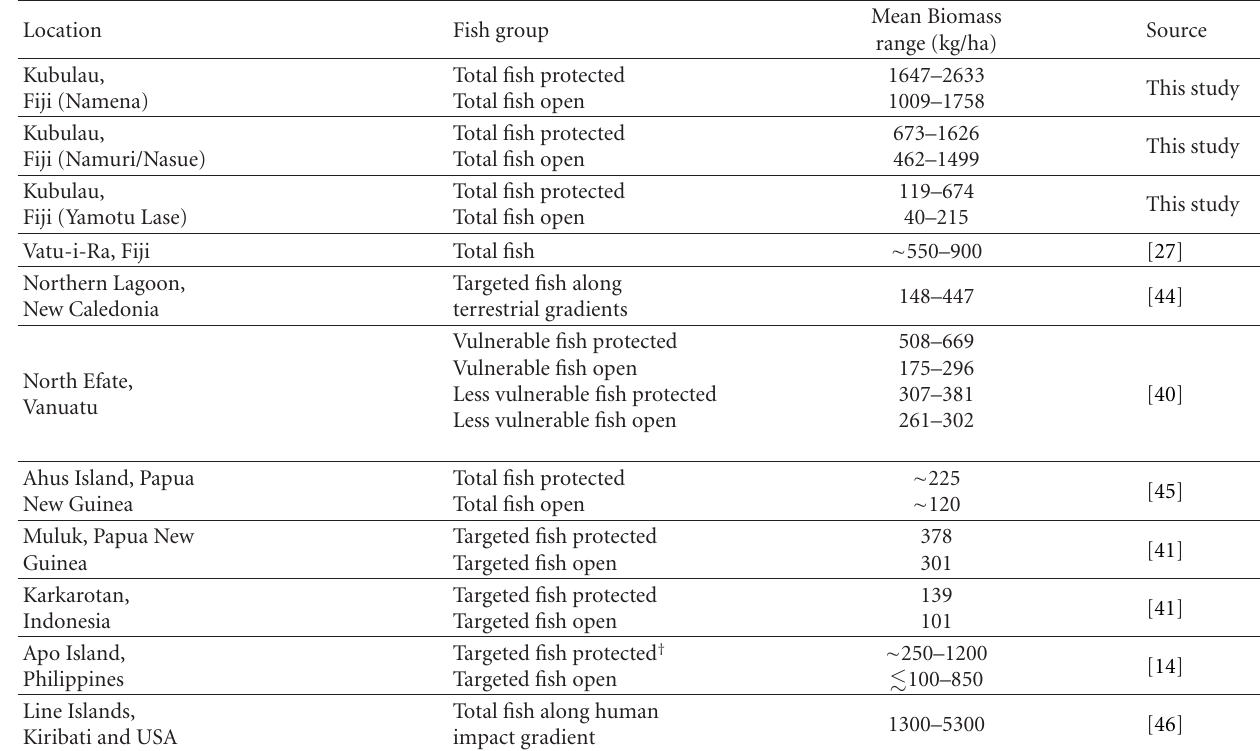
Table 5: Comparison of mean fish biomass (kg/ha) evaluated from underwater visual census (UVC) at protected and fished sites in the